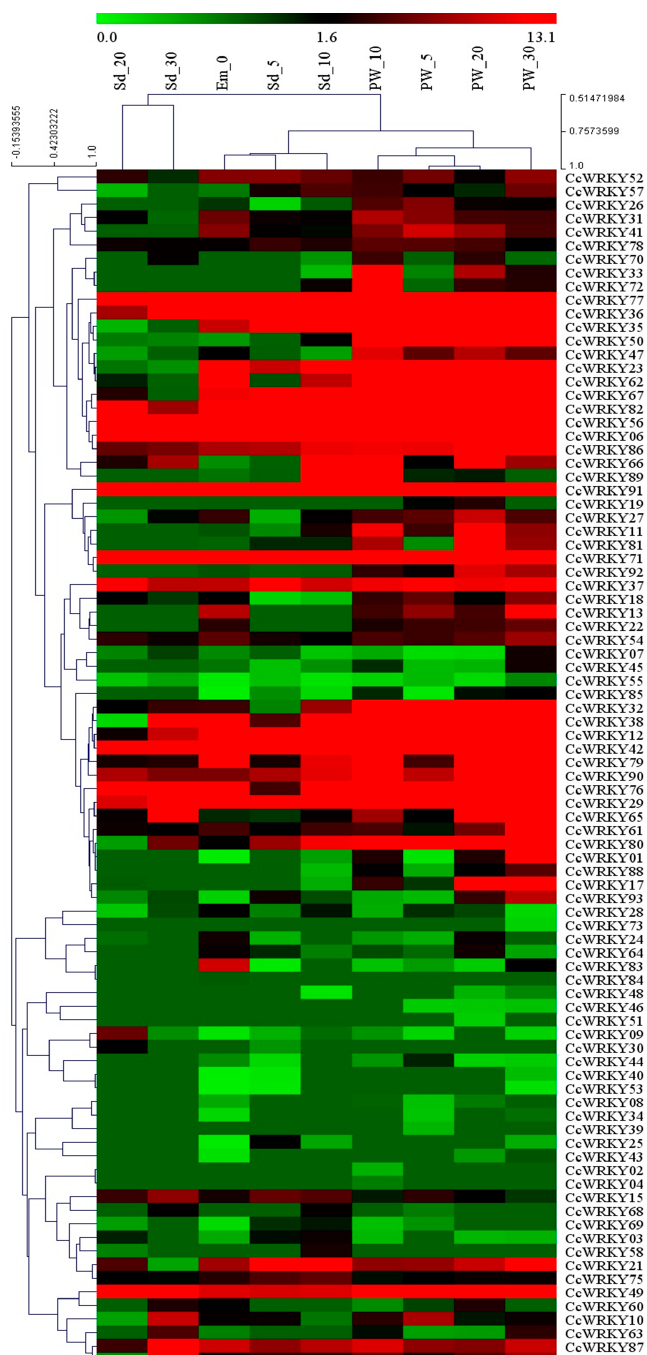
Figure 7. Heat map showing the expression of CcWRKY genes at different developmental stages. The heat map was generated by using fragments per kilobase per million mapped reads (FPKM) values obtained from different developmental stages, embryo sac from the day of anthesis (0 DAA), seed (5, 10, 20, 30 DAA) and pod wall (5, 10, 20, 30 DAA) of pigeonpea cultivar “Asha” (ICPL 87119).